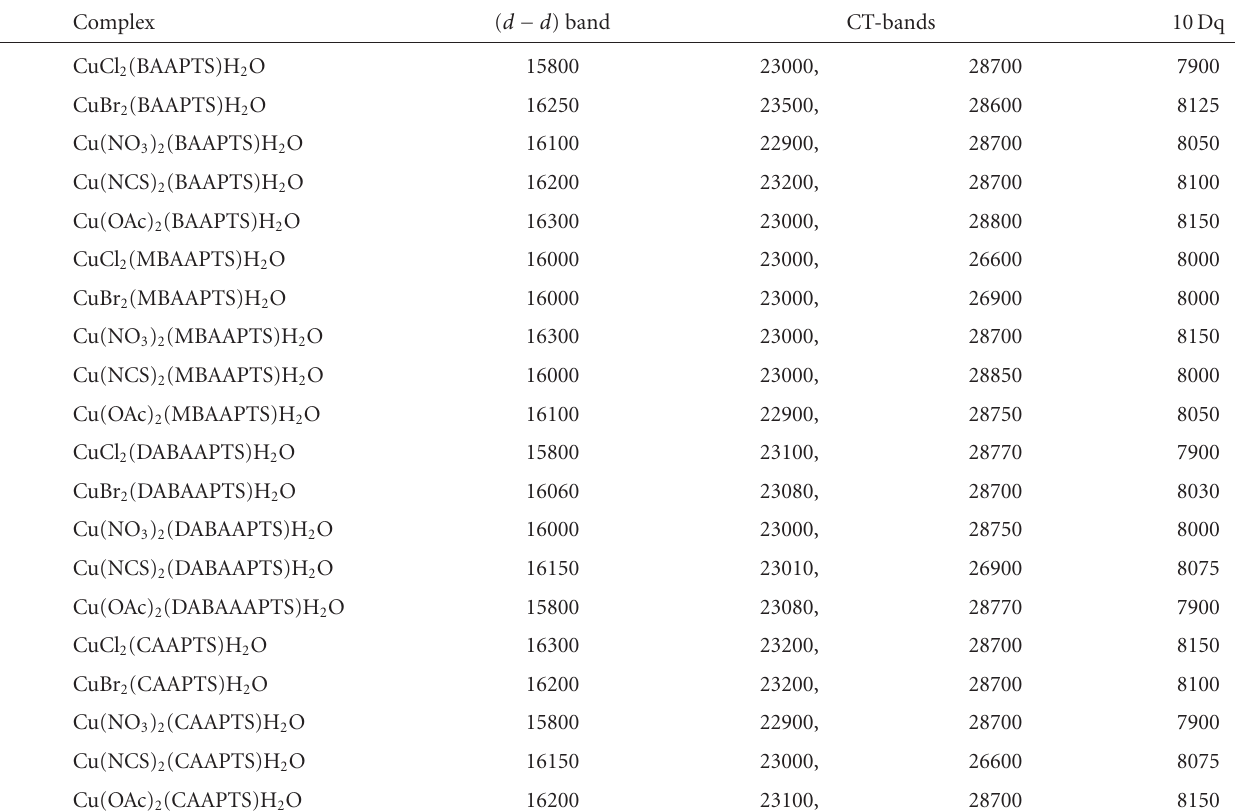
Table 5: Electronic spectral bands (cm − 1 ) of Cu 2+ complexes of thiosemicarbazones.